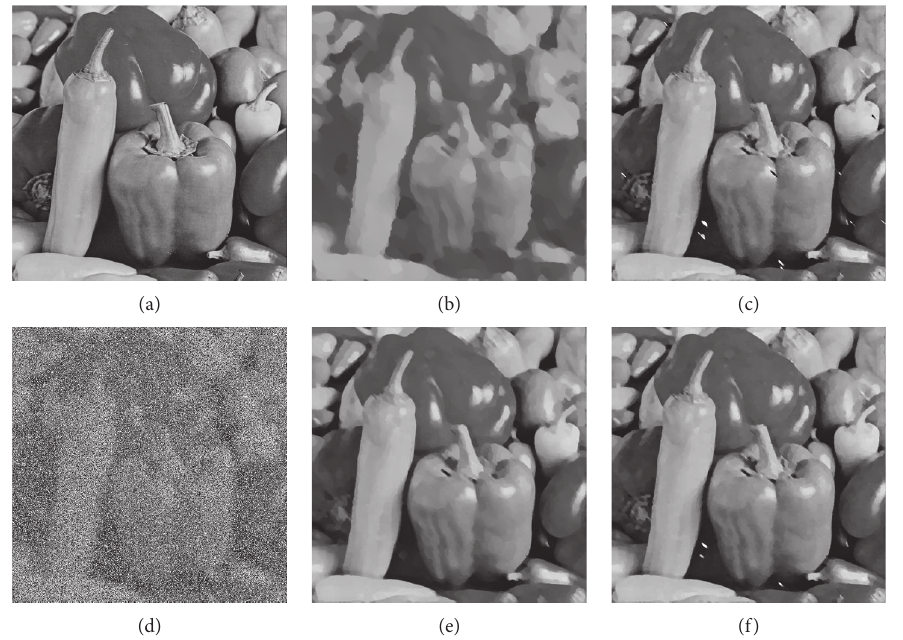
Figure 15: The recovery results (Peppers 512) by Motion blur with 70% RV noise. (a) Original. (b) TVL1, PSNR � 19.1338. (c) TVSCAD, PSNR � 25.9661. (d) Motion blur (lev � 0.7). (e) TVLog, PSNR � 26.1602. (f) LogTVSCAD, PSNR �